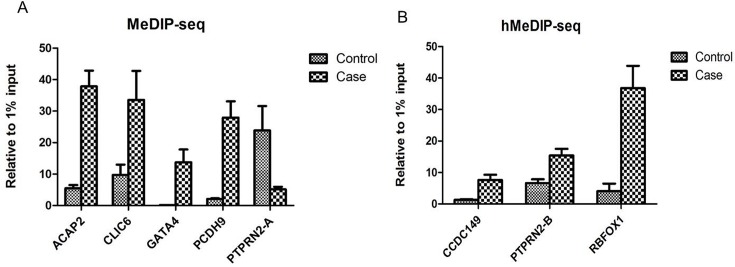
MeDIP-qPCR (A) and hMeDIP-qPCR (B) validations (mean values±SEM, n = 4 per group, p<0.05) of representative DMRs and DHMRs.(A) MeDIP-qPCR validation of ACAP2, CLIC6, GATA4, PCDH9 and PTPRN2-A. (B)hMeDIP-qPCR validation of CCDC149, PTPRN2-B and RBFOX1. ACAP2:p = 0.0032; CLIC6: p = 0.0235; GATA4: p = 0.0429;PCDH9: p = 0.0081; PTPRN2-A: p = 0.0216; CCDC149: p = 0.0068; PTPRN2-B: p = 0.0018; RBFOX1: p = 0.0250.